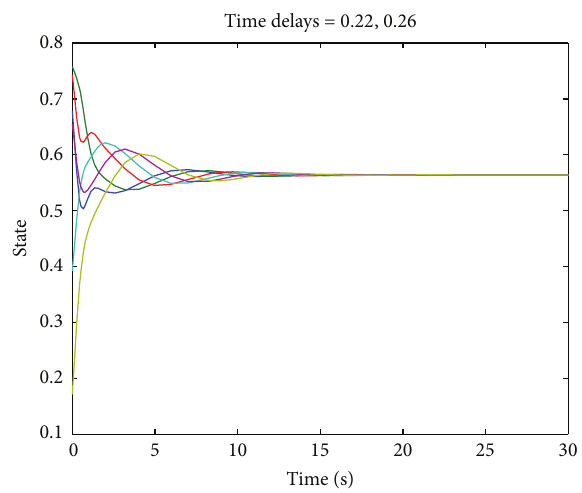
Figure 3: State trajectory of system (1) with G = G 𝑏 .